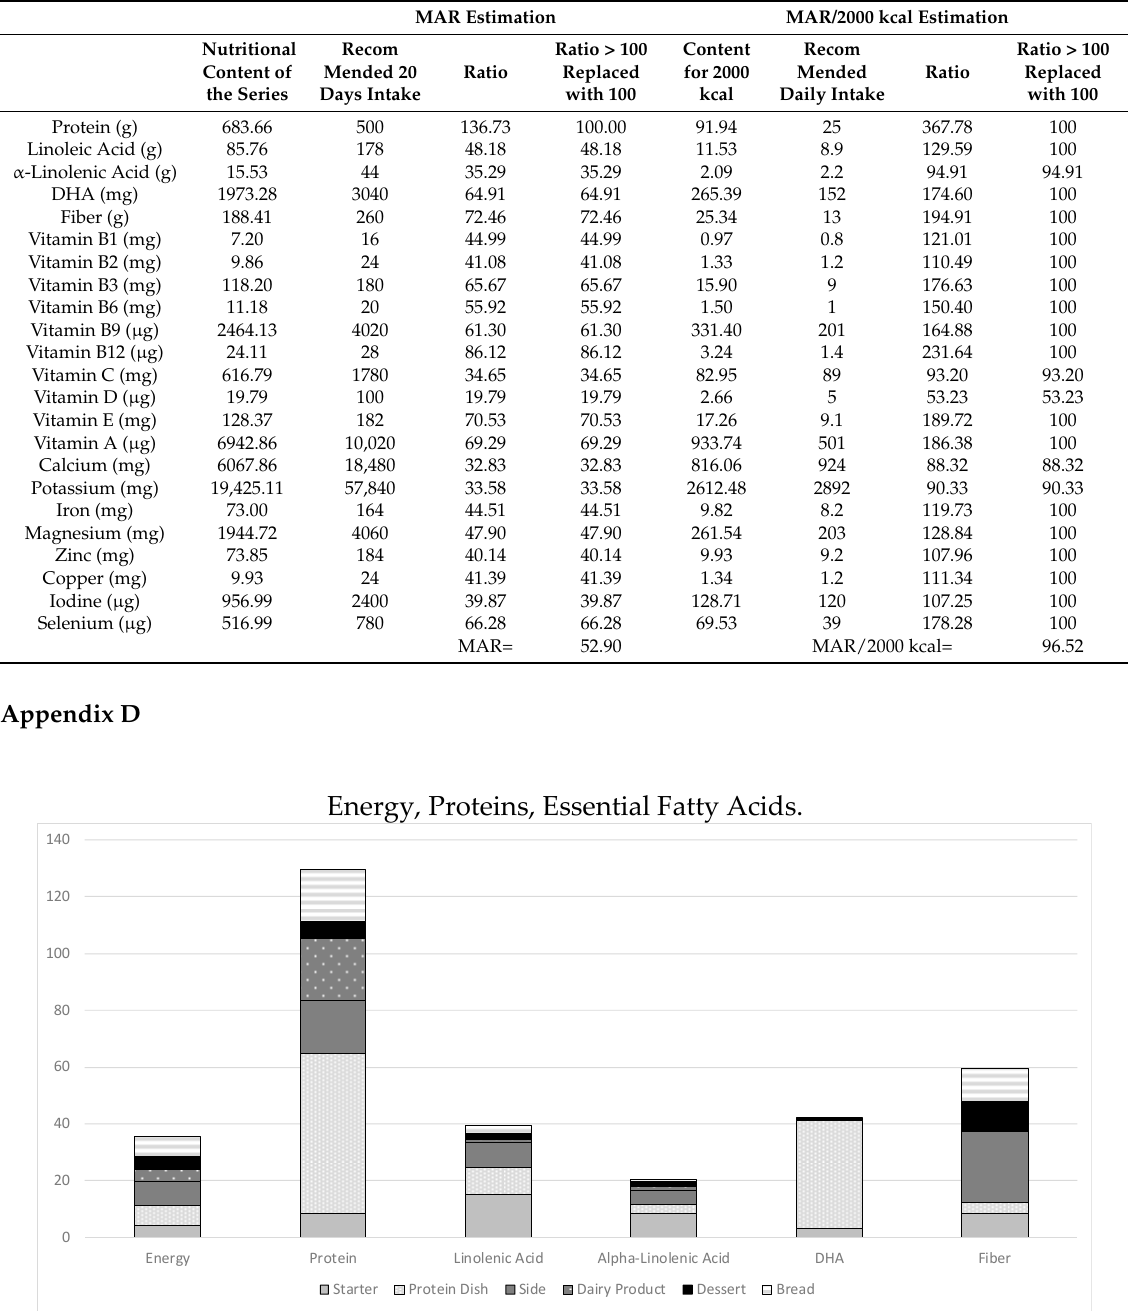
Minerals Figure A1. Average contributions of 5 meal components to the nutrient contents of the observed series ( n = 40 series of 20 meals), expressed in % of daily recommended intakes (multiplied by 20).